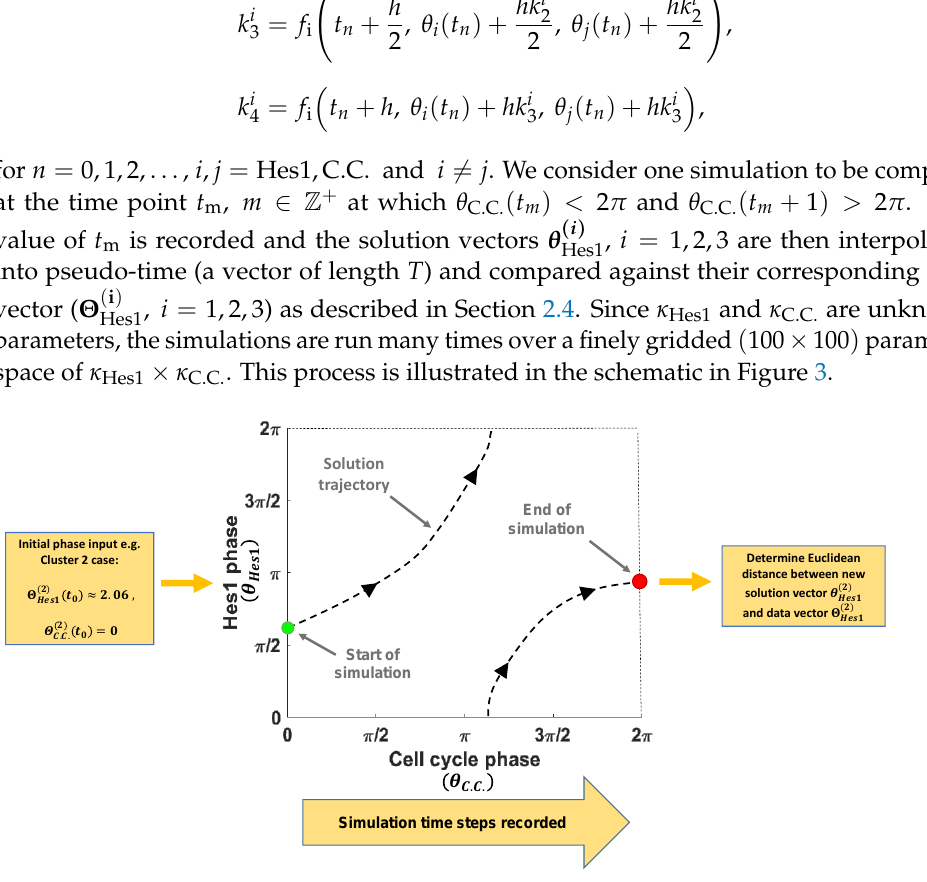
Figure 3. Schematic illustrating our method of developing model simulations with an arbitrary example